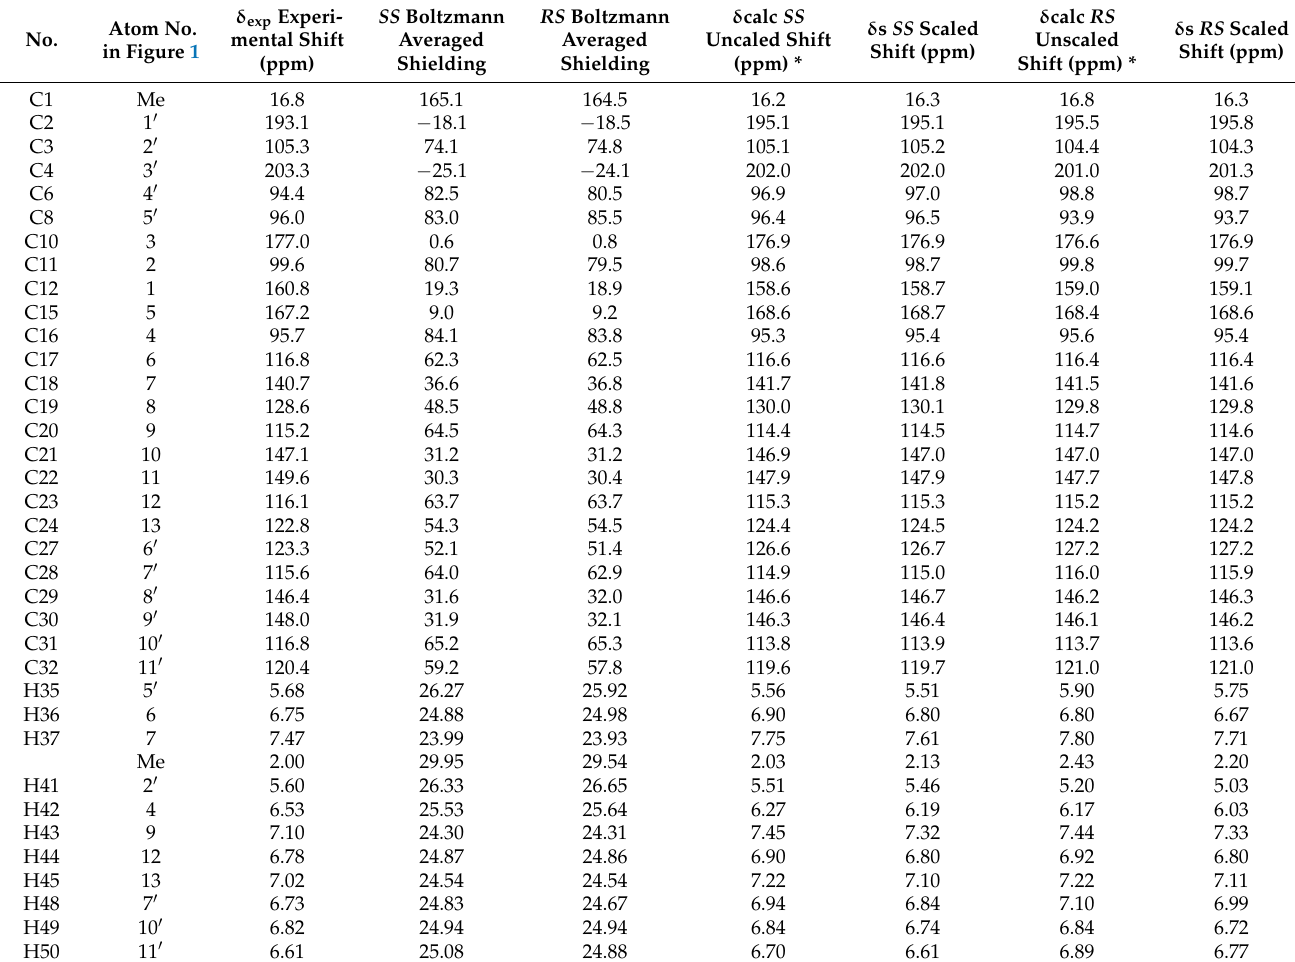
Table 2. Experimental and calculated chemical shifts and isotropic shielding values of S,S and R,S isomers. Atom No. No. in Figure 1